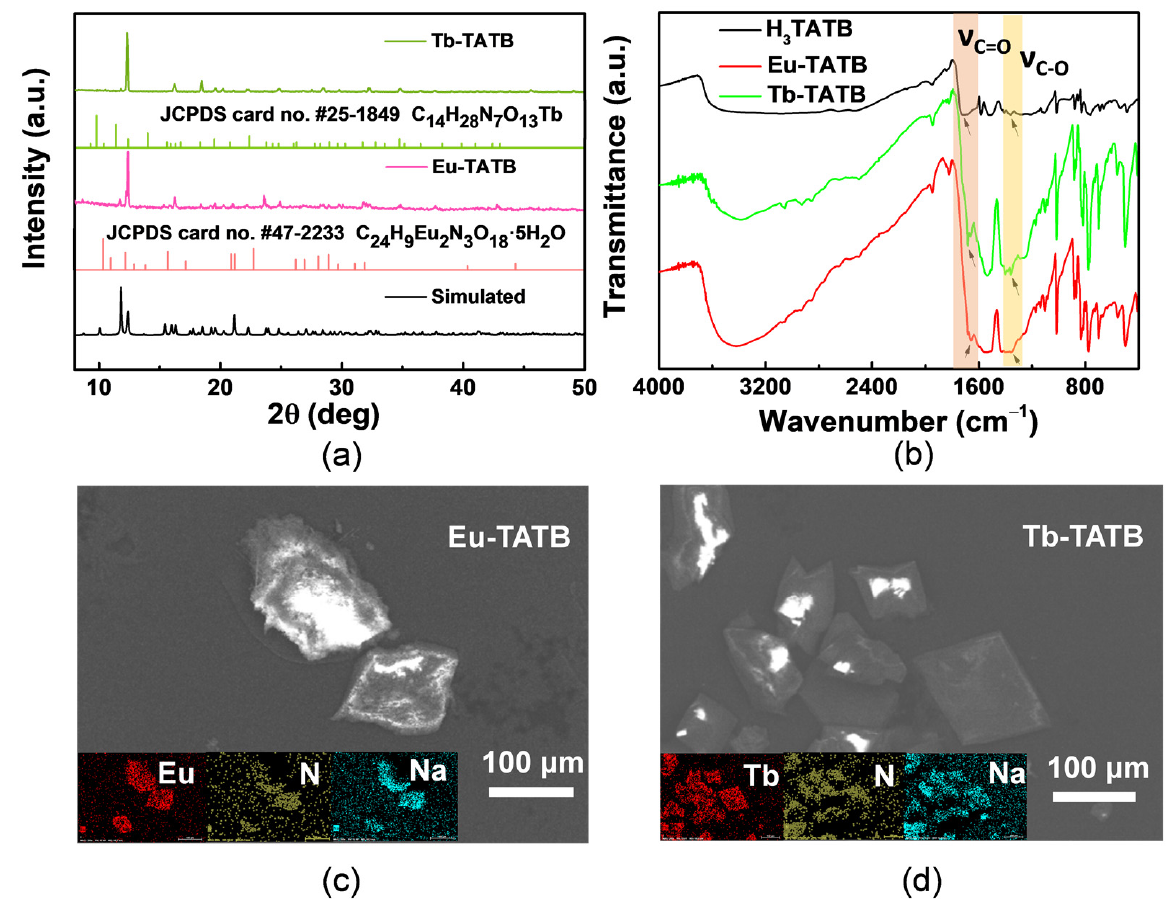
Figure 2. ( a ) PXRD patterns of Eu-TATB, Tb-TATB, and the simulated PRXD pattern. ( b ) FTIR spectra of Eu-TATB, Tb-TATB, and H 3 TATB. SEM images of ( c ) Eu-TATB and ( d ) Tb-TATB. Inserts show the corresponding EDS mapping.